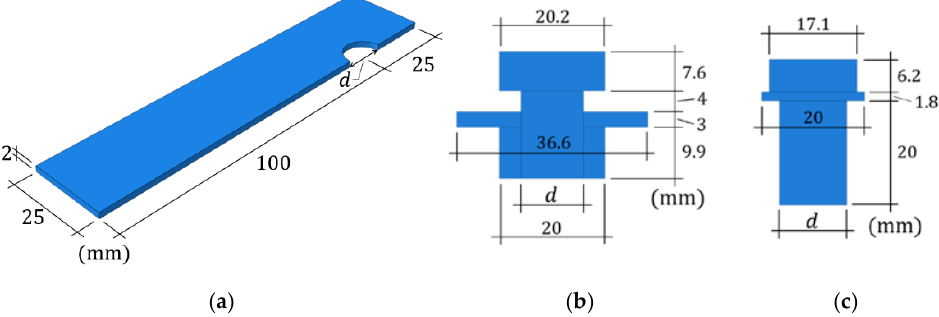
Figure 4. Geometries of the parts of the models: ( a ) plate; ( b ) prestressed bolt; ( c ) nutless bolt.